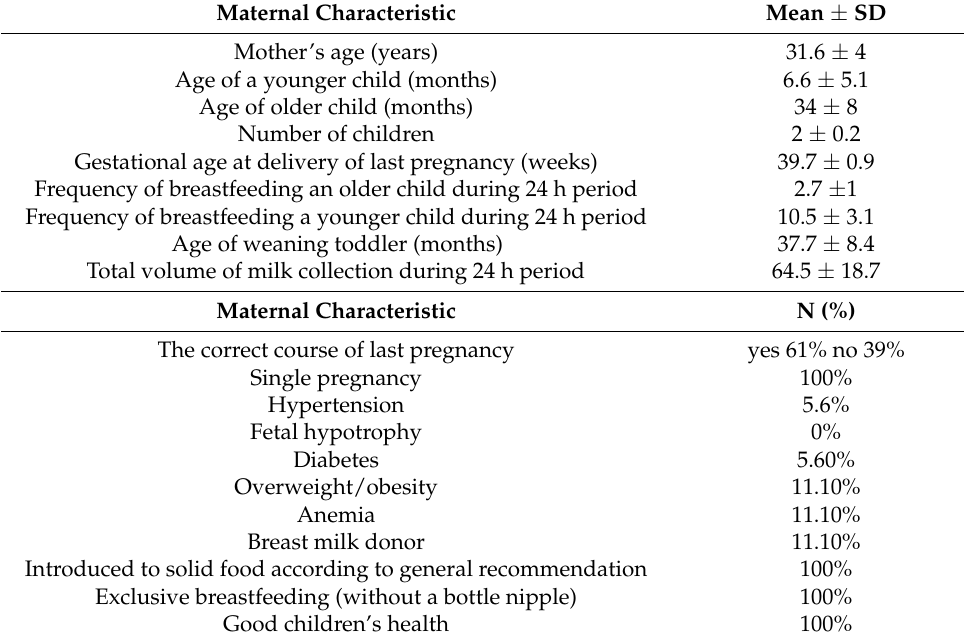
Table 1. Characteristic of tandem breastfeeding mothers